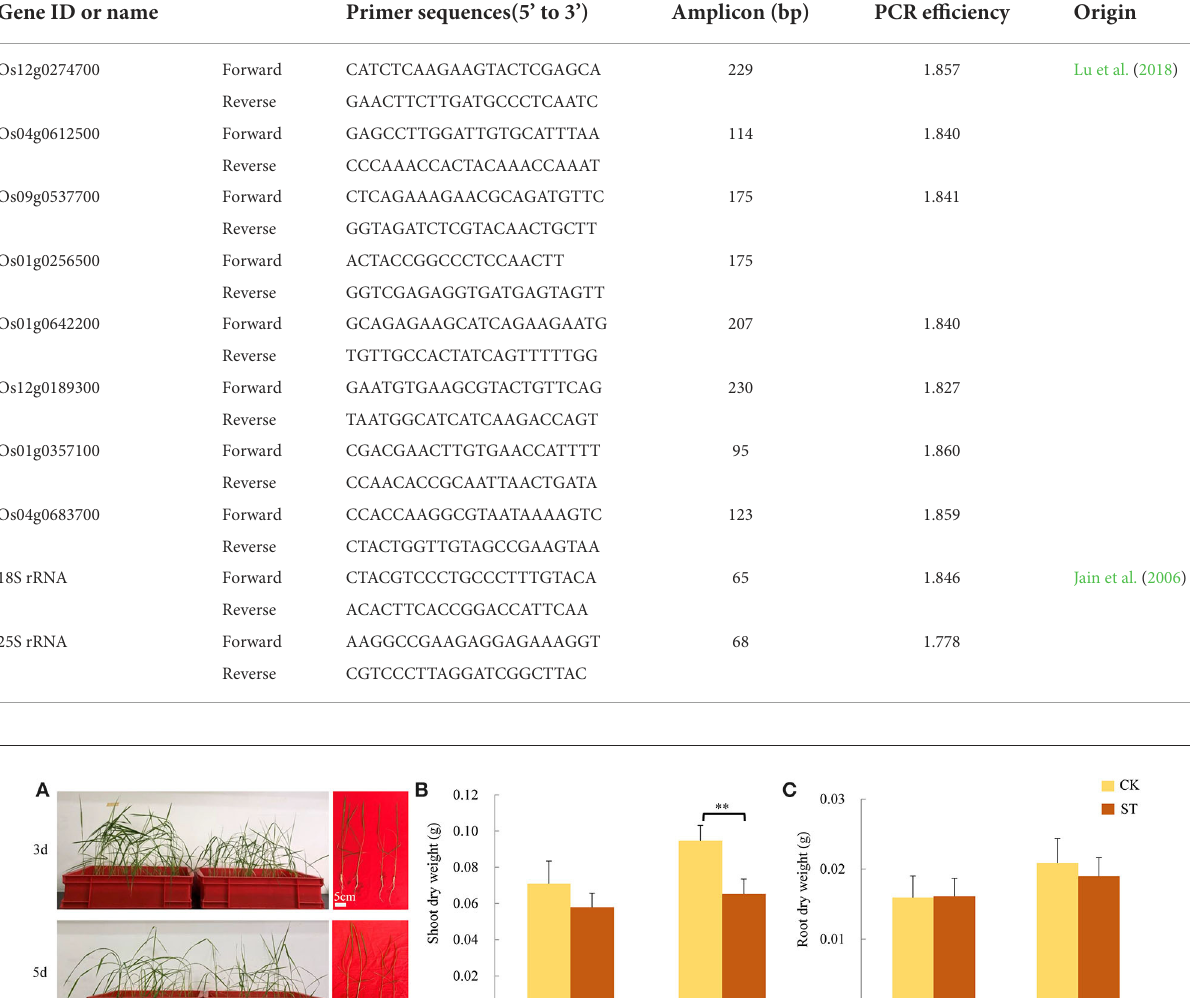
TABLE 2 Primers used in the qRT-PCR analyses.